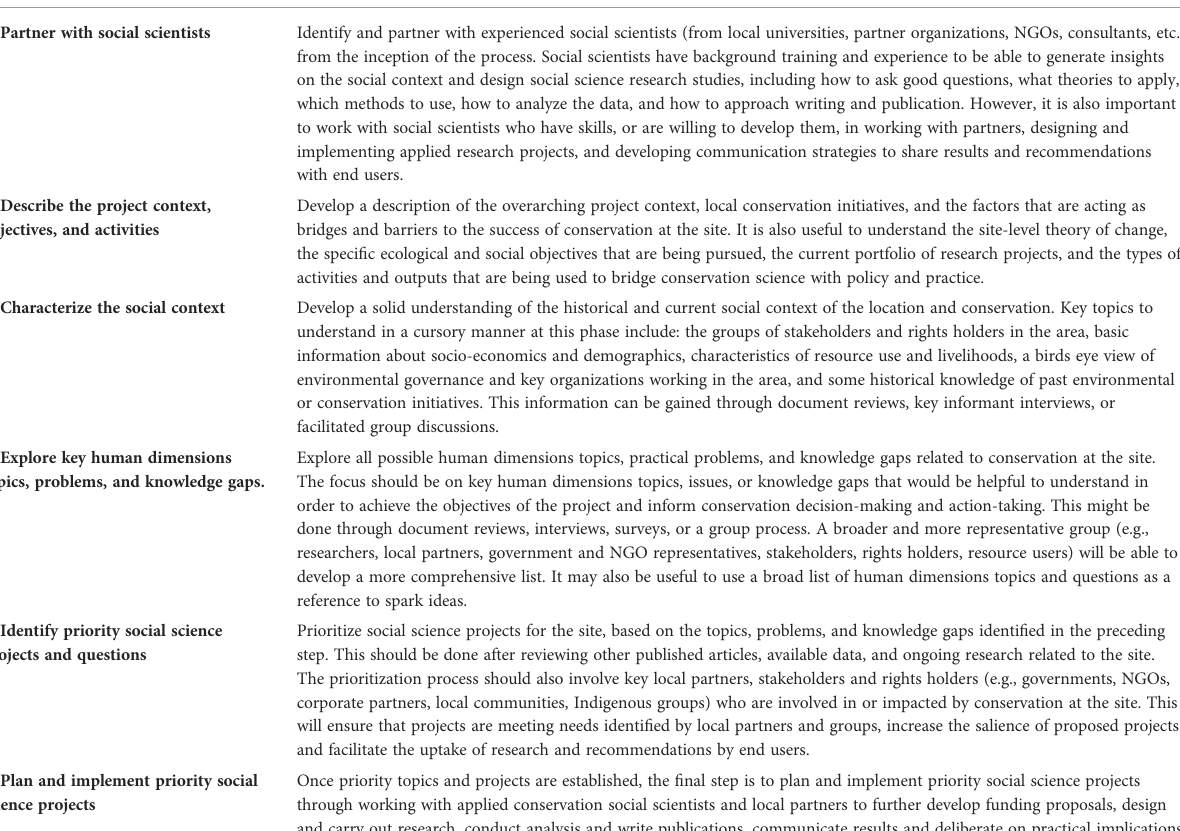
TABLE 4 Steps to identify, prioritize, and develop social science research projects for a working landscape or seascape